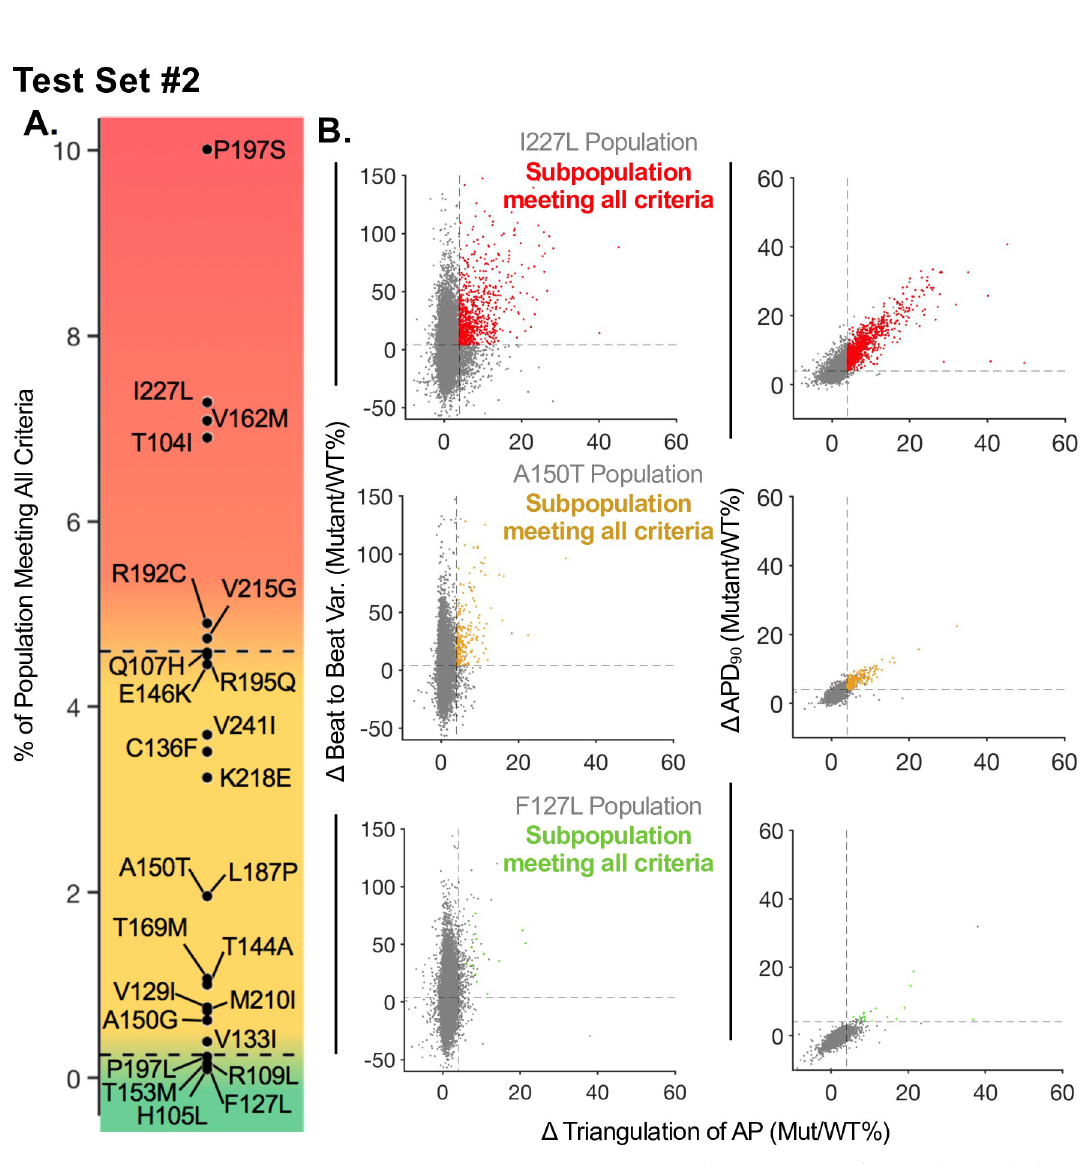
Fig 6. Prediction of LQTS severity in test set 2 using a population-based approach. The severity sorting framework was applied to test set 2 (TS2). TS2 includes mutations with unknown clinical phenotypes. (A) Predicted stratification of LQTS severity for TS2. Red corresponds to the most severe LQTS mutations, green corresponds to benign mutations for LQTS, and yellow highlights the region of severity which cannot be classified utilizing the framework developed with TS1. (B) Three example mutant populations showing the subpopulation of cells meeting the set criteria. Red highlighted points in the top row represent the 7.28% of cells in the I227L population which surpass the 4% threshold for all three criteria. Yellow highlighted points in the middle row represent the 1.96% of cells in the A150T population which surpass the 4% threshold for all three criteria. Green highlighted points in the bottom row represent the 0.16% of cells in the F127L population which surpass the 4% threshold for all three criteria.